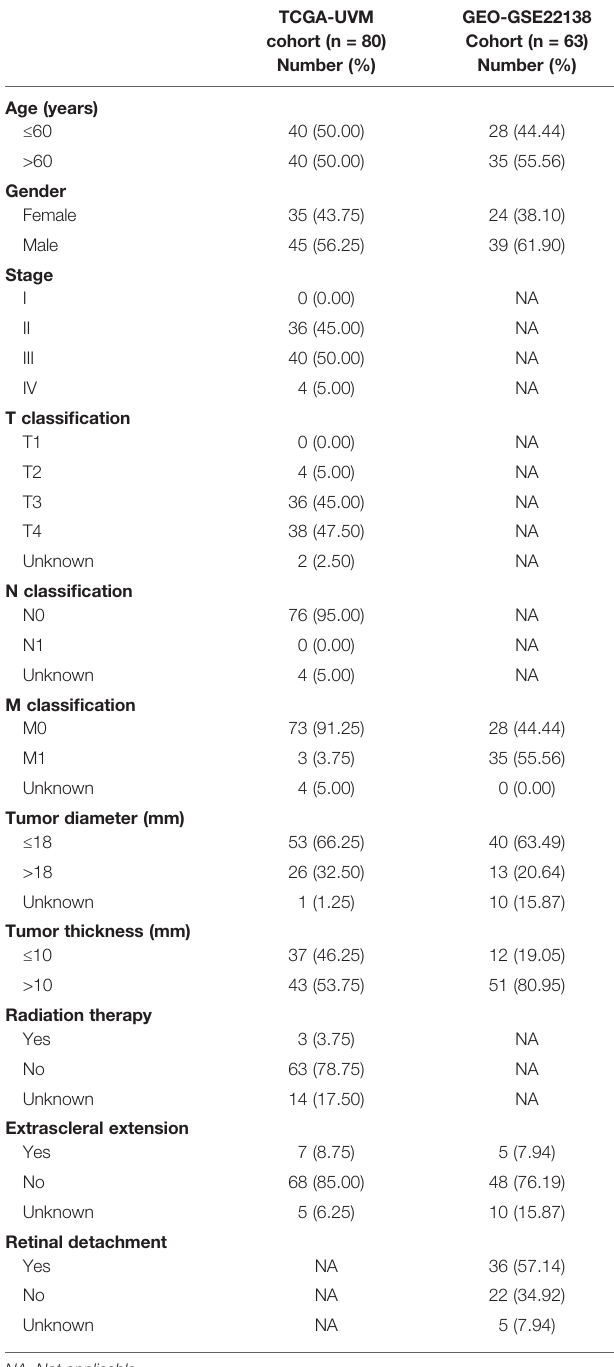
TABLE 1 | Baseline characteristics of UM patients included in this